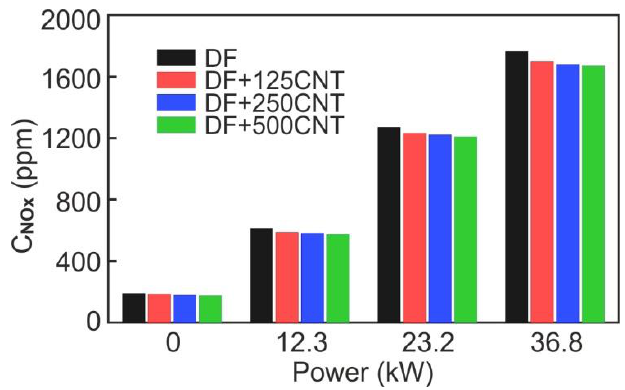
) in exhaust gas depending on the amount of CNT addition x